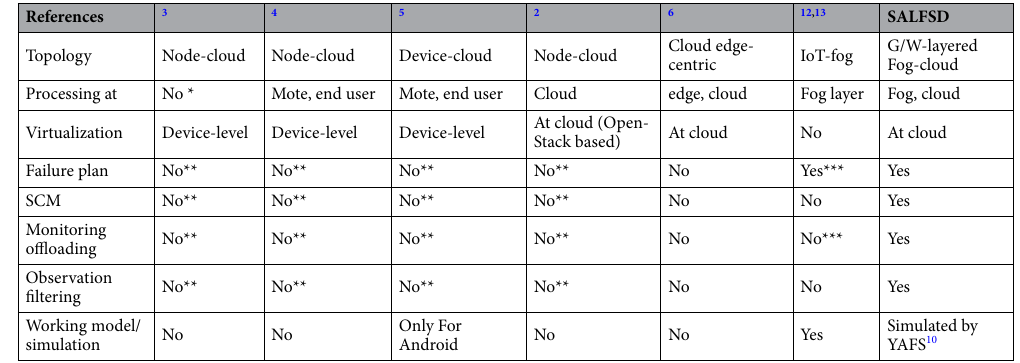
Table 1. Comparison of proposed work with related